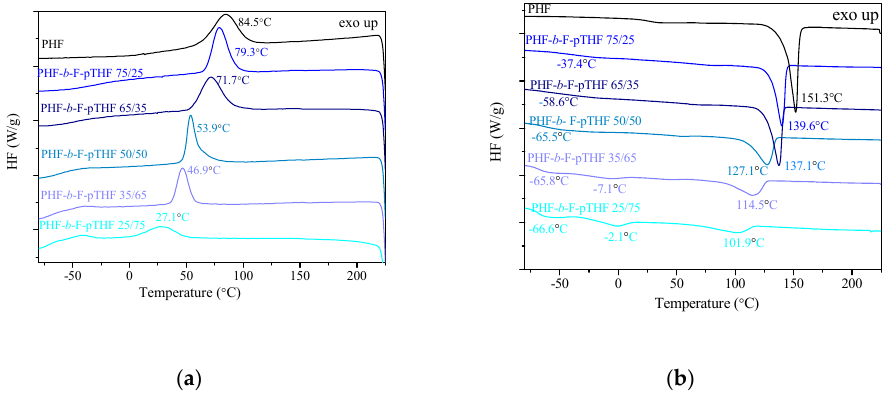
Figure 4. Differential scanning calorimetry (DSC) thermograms for homopolymer PHF and PHF- b -F-pTHF copolymers recorded during: ( a ) cooling and ( b ) second heating.